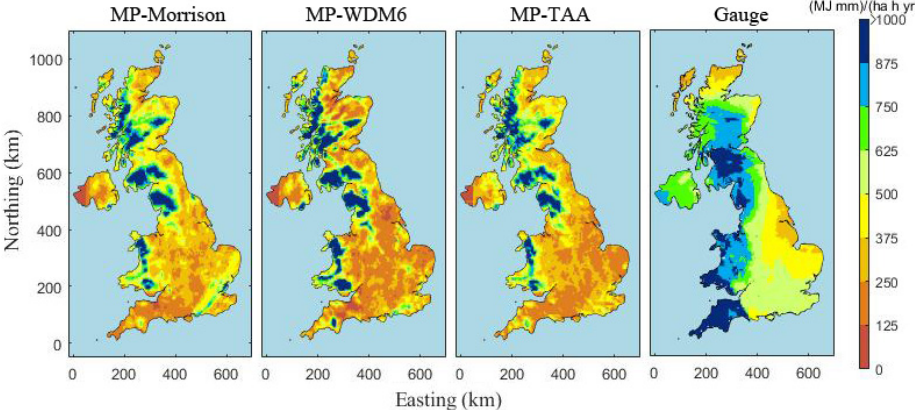
Figure 10. The 5-year (2013–2017) average annual rainfall erosivity maps based on WRF grids and rain gauge